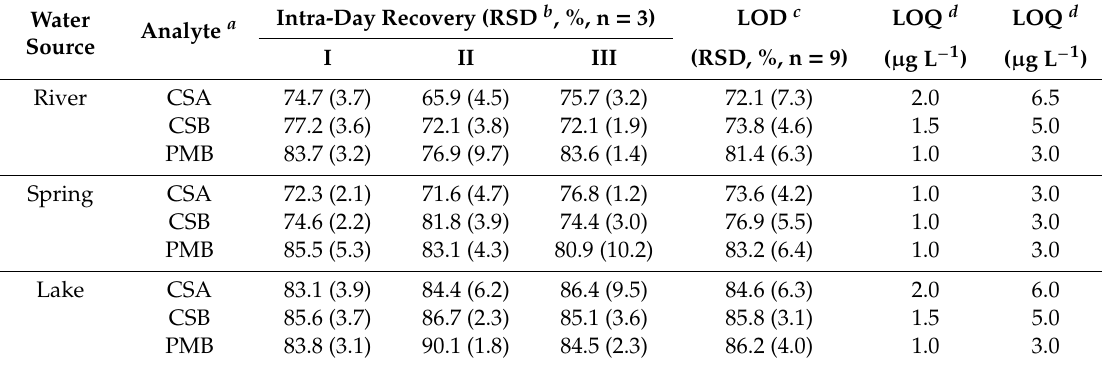
Table 1. Accuracy, precision, limit of detection and limit of quantification of colistin A, colistin B and polymyxin B from di ff erent kinds of water samples spiked with the mixture of target analytes (10 µ g L − 1 for each) after MISPE